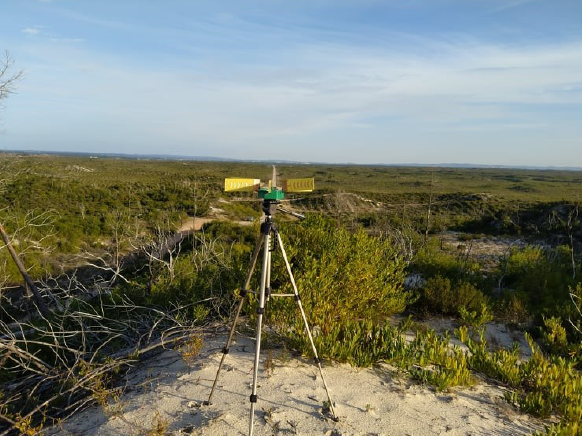
Figure 15. Photography of the BS placement on the WSN range campaign in Poço do Inglês, Mar- inha Grande.